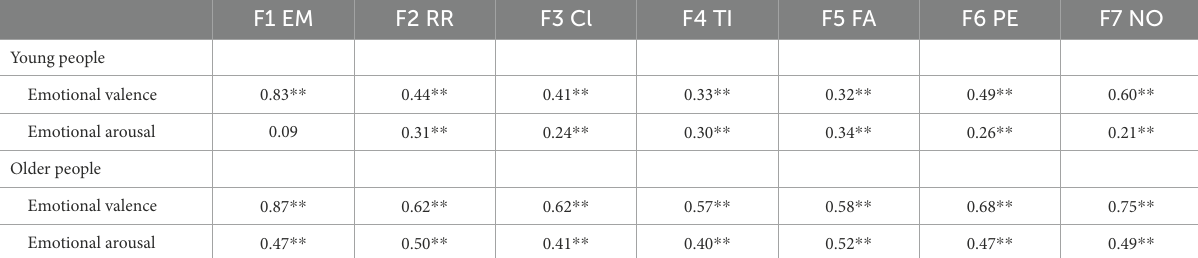
TABLE 4 Correlation coefficients between the OEAMQ subscales and odor-induced emotional items by each